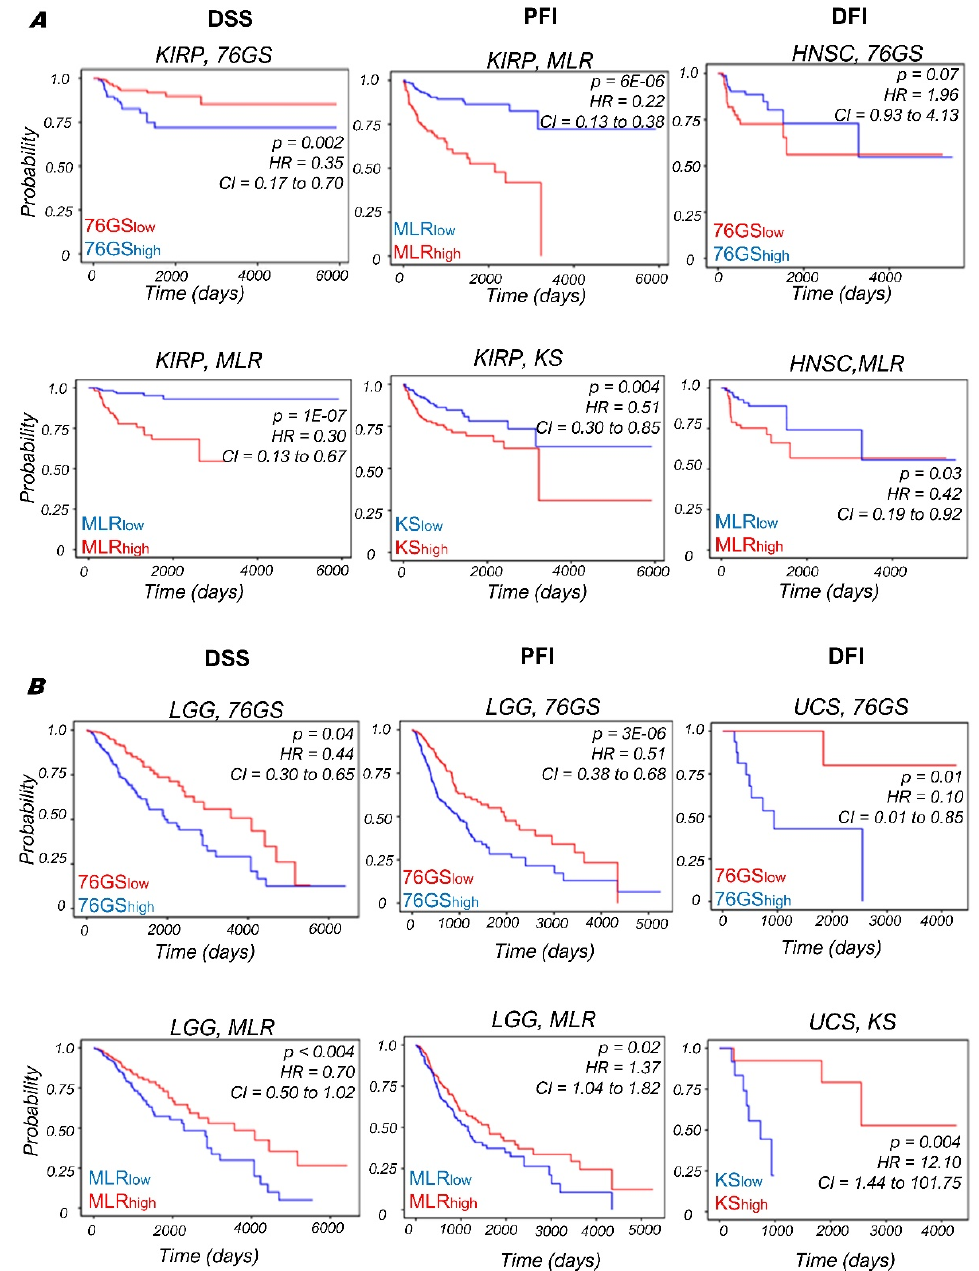
Figure 6. Correlation between EMT score (high vs. low) and various survival types (DSS, PFI, and DFI) in various TCGA datasets. Kaplan–Meier survival analysis is performed to estimate differences in survival for different EMT metrics. p -values ( p ) reported are based on the log rank test. The values of Hazard ratio (HR) with 95% confidence interval (CI) values are included. ( A ) Plots for (kidney renal papillary cell carcinoma (KIRP) and Head and Neck Squamous Cancer (HNSC). ( B ) Plots for low-grade glioma (LGG) and uterine carcinosarcoma (UCS).